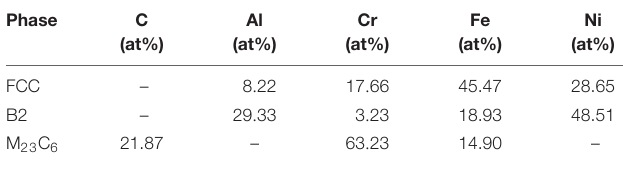
TABLE 2 | Characteristic EDS measurements of phases in homogenized AlCrFe 2 Ni 2 in atomic